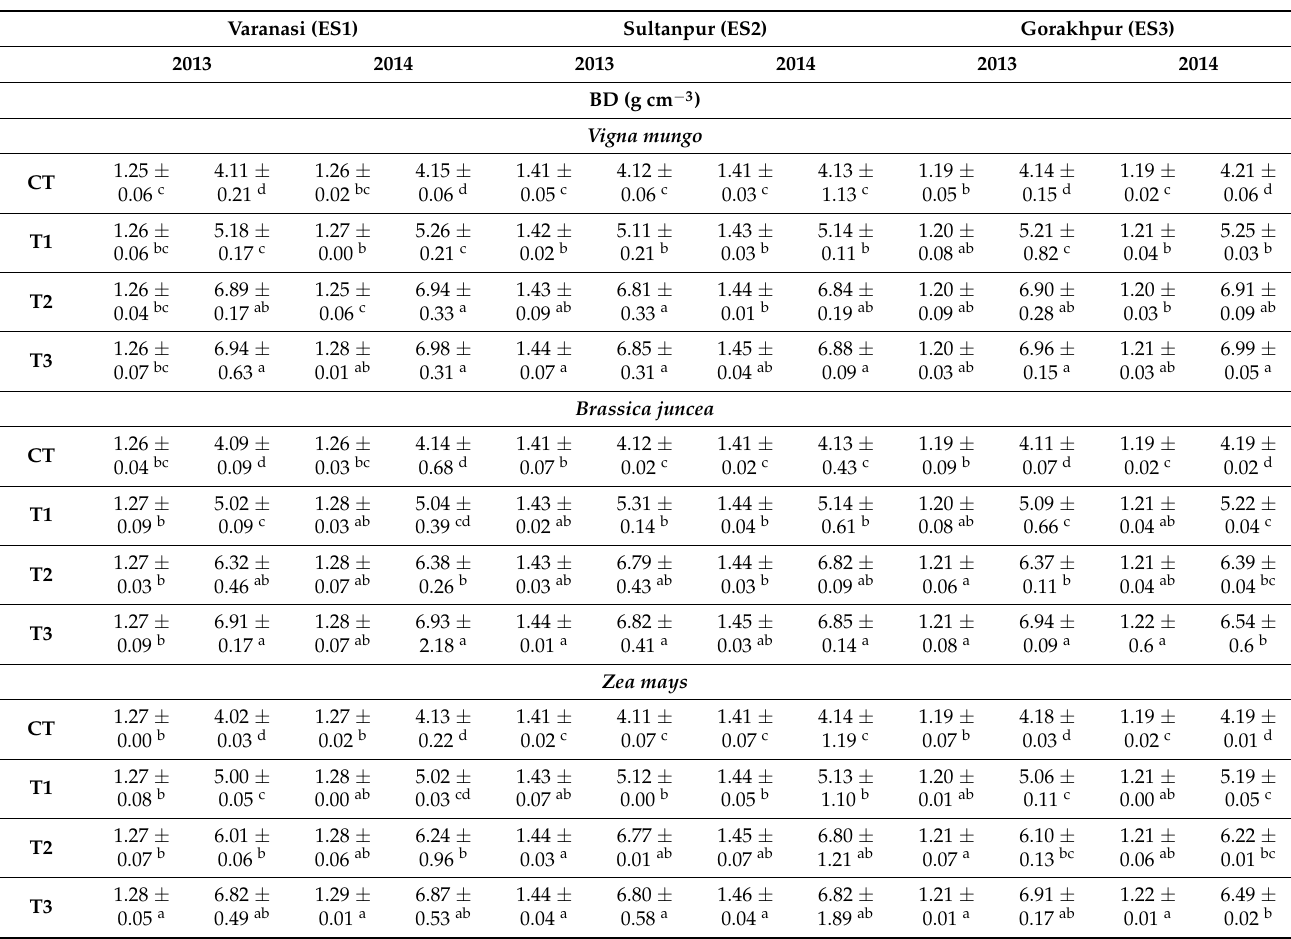
Table 3. Bulk density and total organic carbon changes in V. mungo, B. juncea, and Z. mays grown at three different sites. Data are the mean values of different practices. Data followed by different letters were significantly different ( p = 0.05) CT: control field with conventional agronomic practices and tillage; T1: AMF (RT); T2: Biochar (RT); T3: AMF + Biochar (RT). AMF = Arbuscular mycorrhizal fungi; RT = Reduced